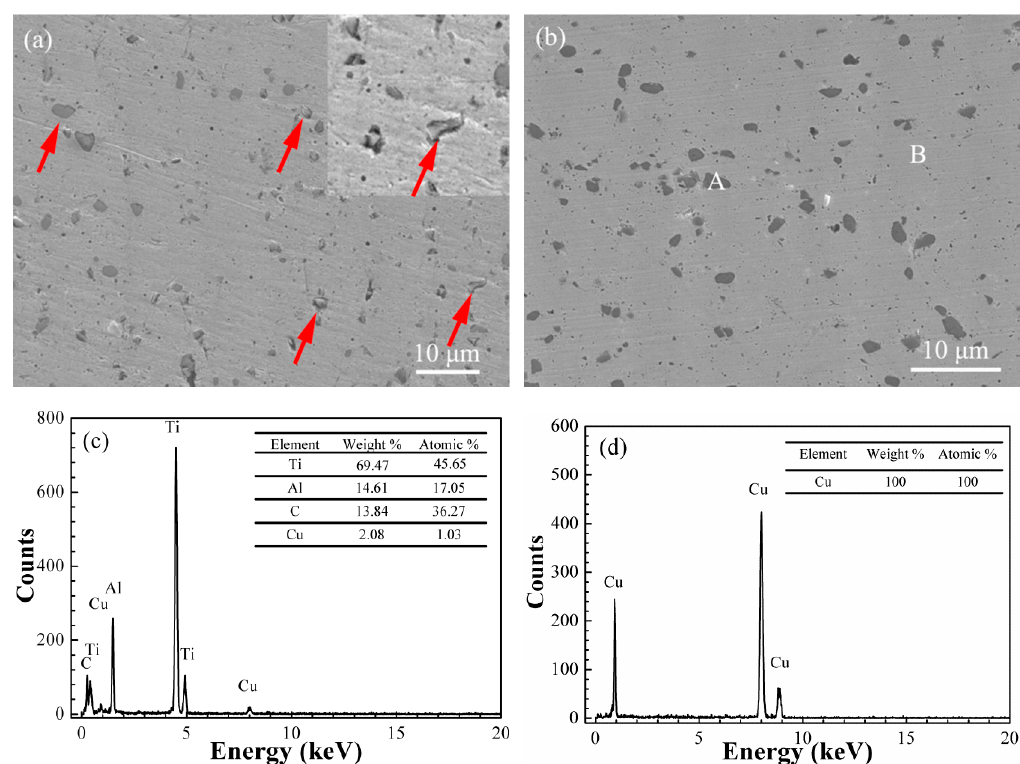
Figure 5. The distribution of the Ti 3 AlC 2 particles in the Cu matrix: ( a ) Ti 3 AlC 2 -Gd 2 O 3 /Cu; ( b ) Cu@Ti 3 AlC 2 -Gd 2 O 3 /Cu; ( c , d ) are the energy spectra of areas A and B in Figure 5b; small cracks and micropores were indicated by red arrows.